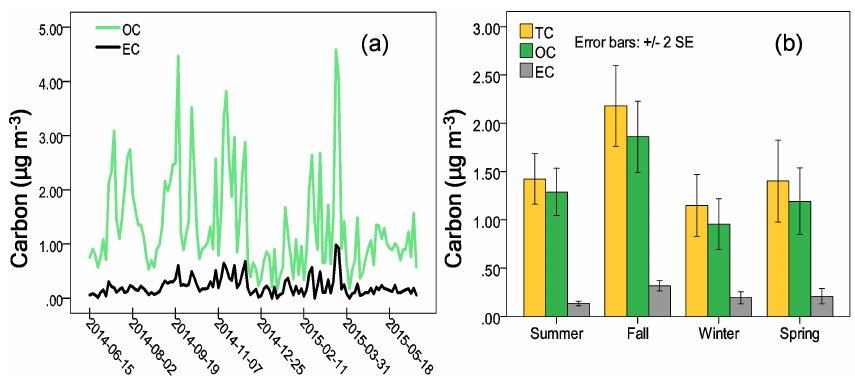
Figure 1. Temporal variations in OC, EC and TC. Panel (a) shows the temporal variation in OC and EC with a time resolution of 72h ( N = 123). Panel (b) displays the average concentration of TC, OC and EC divided into seasons: summer ( N = 32), fall ( N = 30), winter ( N = 30) and spring ( N = 31). Error bars display ± 2 standard errors (SE).